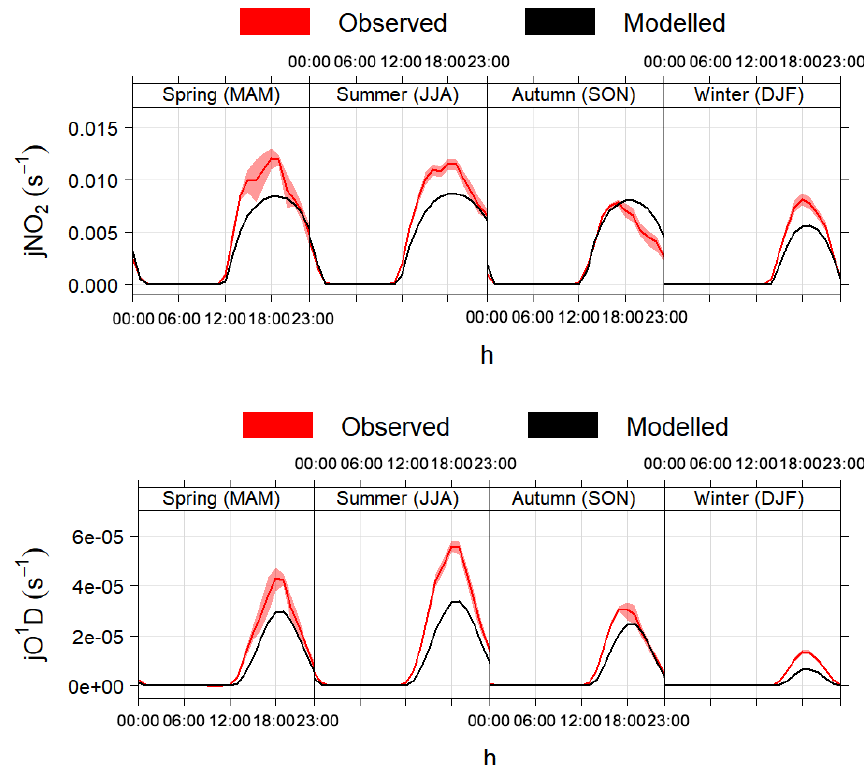
Figure 4. Average modelled and measured j (NO 2 ) and j (O 1 D) during different seasons in Boulder, CO, USA. The shaded areas are the 95% confidence intervals of the mean. The timestamp is in Greenwich Mean Time, which is the timezone used by AtChem (local time is GMT − 7 from November to February and GMT − 6 from March to